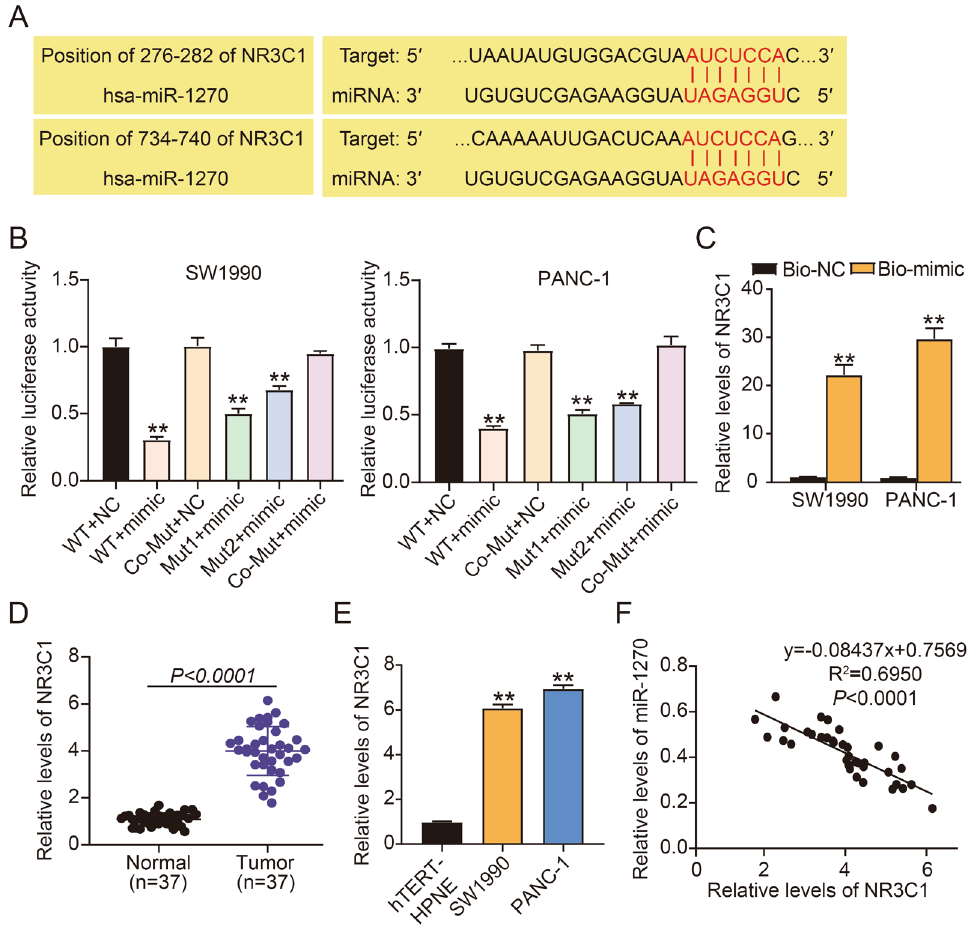
Figure 6. NR3C1 was directly targeted by miR-1270. ( A ) The binding sites between miR-1270 and NR3C1 were predicted by TargetScan. ( B ) The binding relationship between miR-1270 and NR3C1 was further testified by dual-luciferase reporter assay. ** P < 0.001 relative to WT + NC. ( C ) The binding relationship between miR-1270 and NR3C1 was verified by pull-down assay. ** P < 0.001 relative to Bio-NC. ( D ) NR3C1 expression in tumor samples and normal samples was examined by RT-qPCR. ( E ) NR3C1 expression in PC cell lines (SW1990 and PANC-1) and non-cancer cell line (hTERT-HPNE) was examined by RT-qPCR, ** P < 0.001 relative to hTERT- HPNE. ( F ) The association between NR3C1 and miR-1270 expression in tumor samples was analyzed by Pearson’s correlation